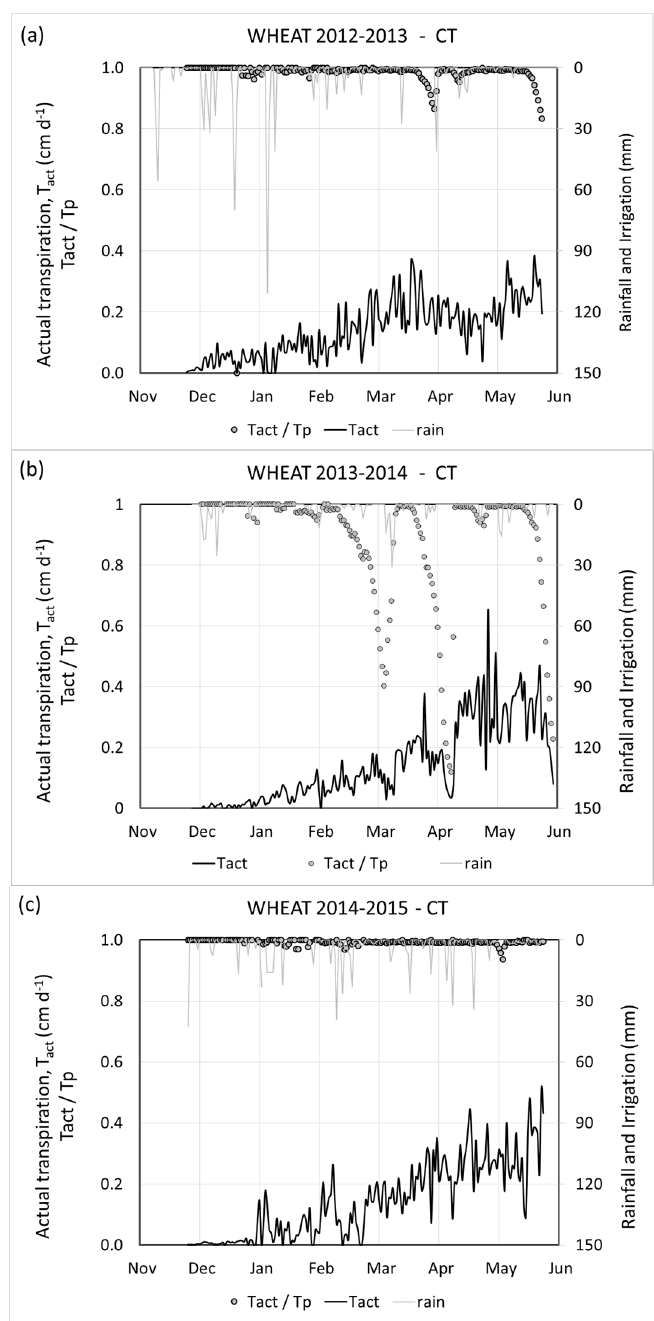
Figure 4. Actual transpiration (T act ), ratio between actual transpiration and potential transpiration (T act / T p ) and rainfall in the three growing seasons for wheat under conventional tillage